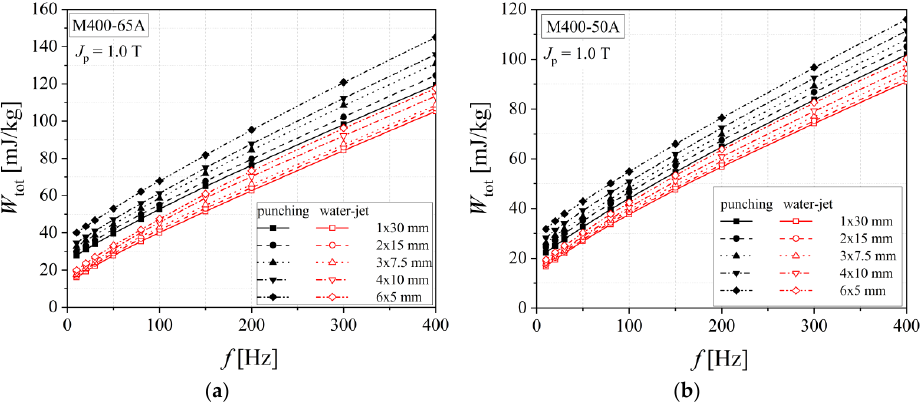
Figure 11. Total energy loss versus frequency dependencies of electrical steel grade M400-65A ( a ) and M400-50A ( b ), in the case of two cutting technologies.